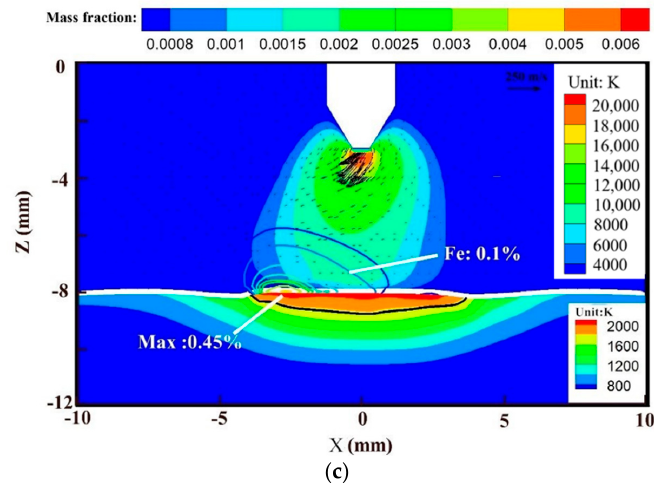
Figure 15. Metal vapor distribution: ( a ) I e = 0 A ( yoz plane), ( b ) I e = 3 A ( yoz plane), and ( c ) I e = 3 A ( xoz plane).